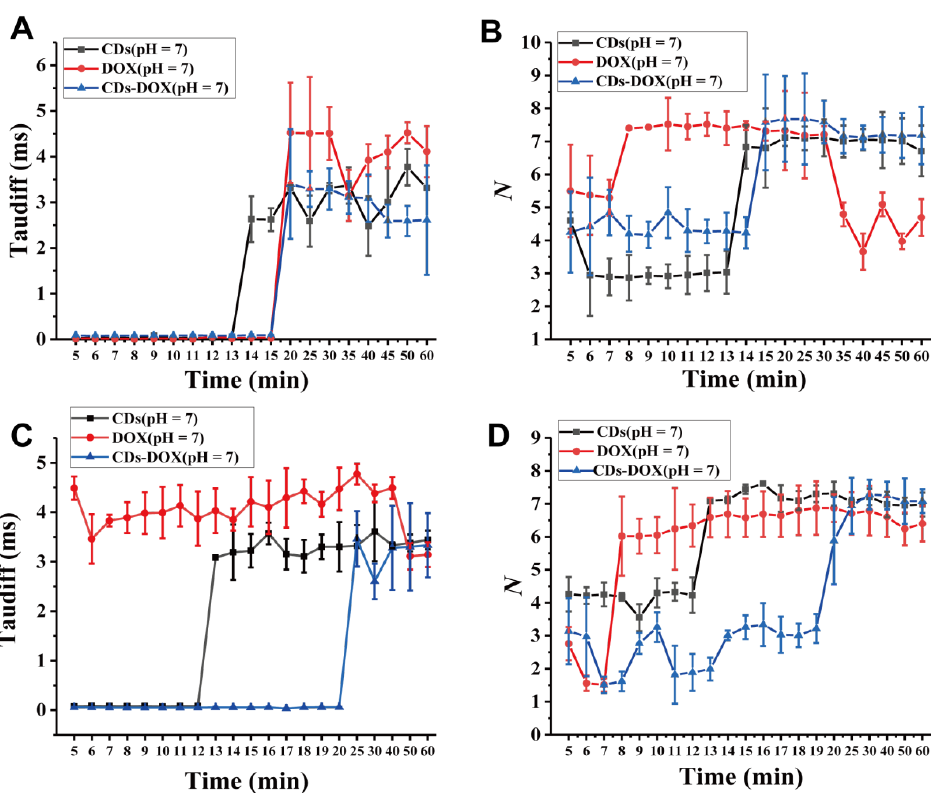
Figure 3. The diffusion times ( τ D ) and mean particle numbers (N) of the CDs, DOX and CDs-DOX in U 2 OS and COS7 cells at different times. ( A , B ) Diffusion times and mean particle numbers of the three particles in U 2 OS cells at different times. ( C , D ) Diffusion times and mean particle numbers of the three particles in COS7 cells at different times. Error bars are given as the mean values ± standard deviation (SD) obtained from multiple samples (n = 9).